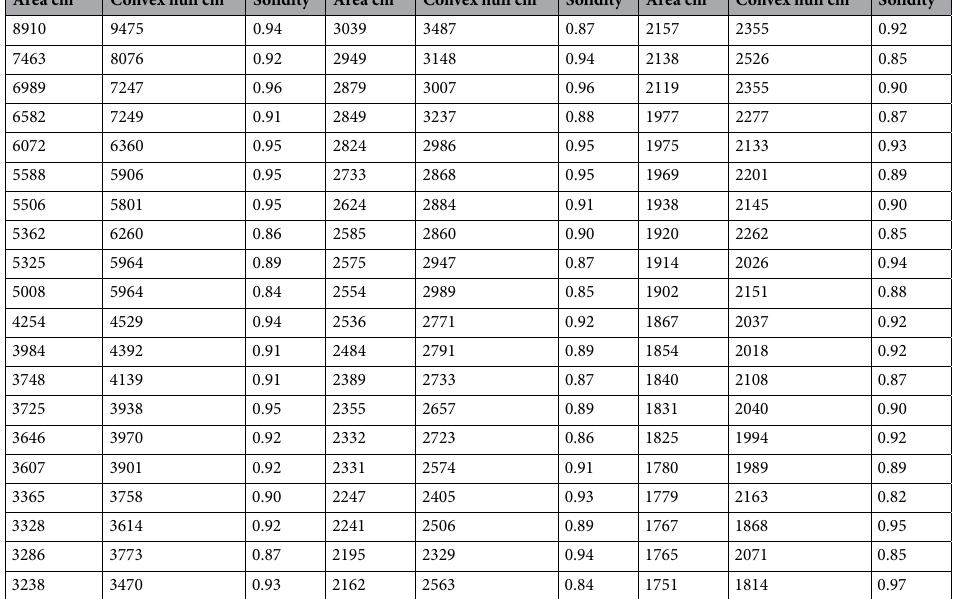
Table 1. Limestone rock block information.